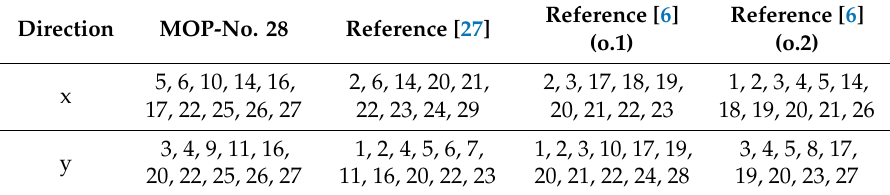
Table 2. Optimal sensor placement (OSP) node ID of the Canton Tower when using 20 sensors with di ff erent methods. MOP-No.